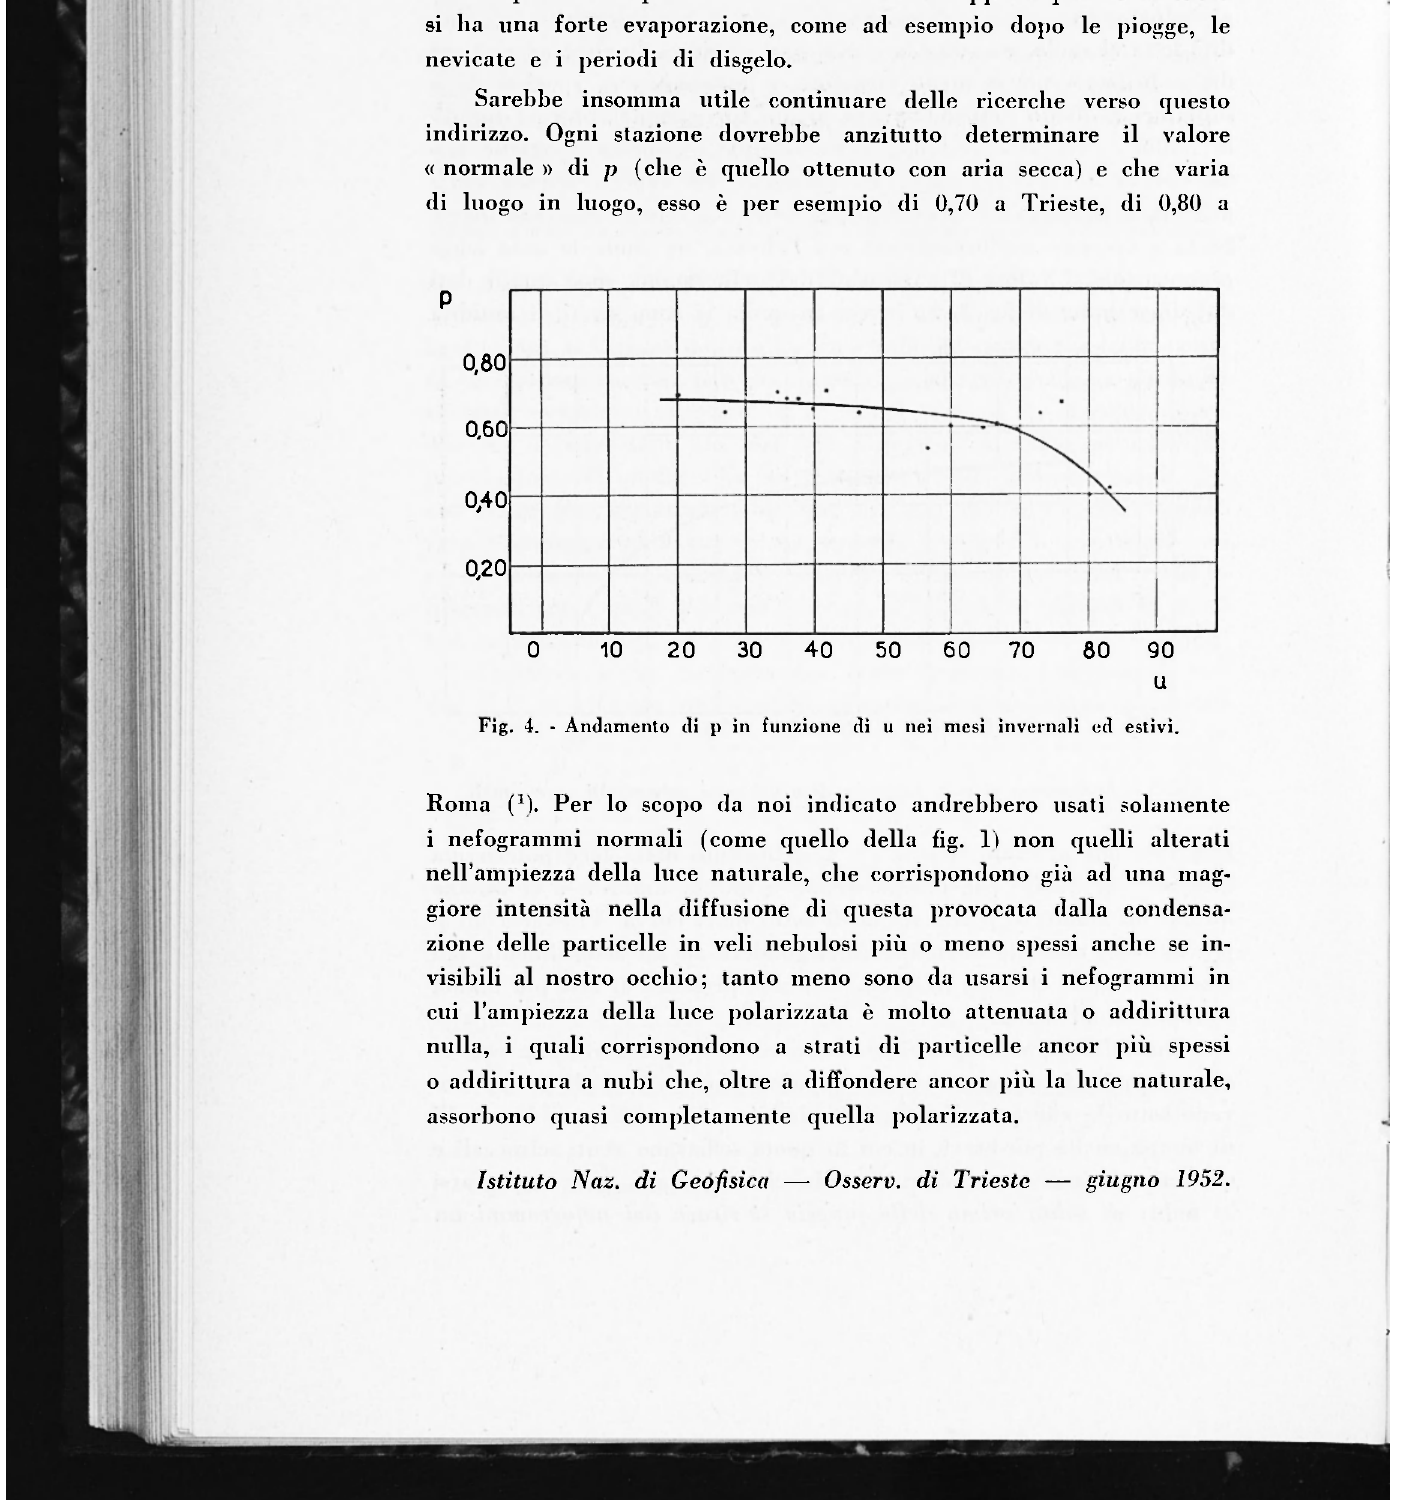
Fig. 4. - Andamento di p in funzione di u nei mesi invernali ed estivi.